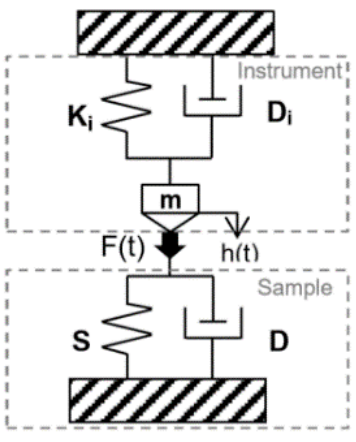
Figure 5. Dynamic mechanical model of viscoelastic material [42].